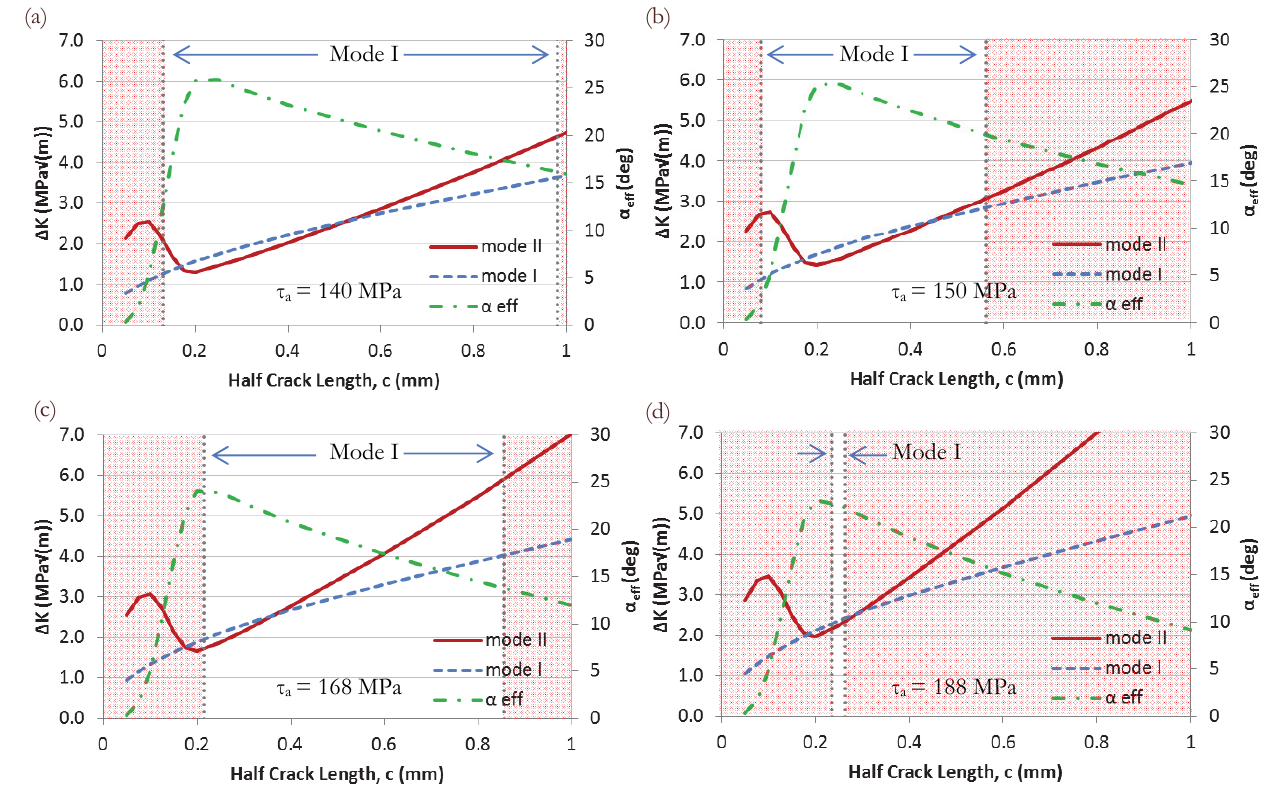
Figure 8: Effective mode II SIF, local mode I SIF, and effective coefficient of friction vs. crack length for fully-reversed pure torsion loadings of (a) 140 MPa, (b) 150 MPa, (c) 168 MPa, and (d) 188 MPa. All results represent LEFM applicable regions of crack